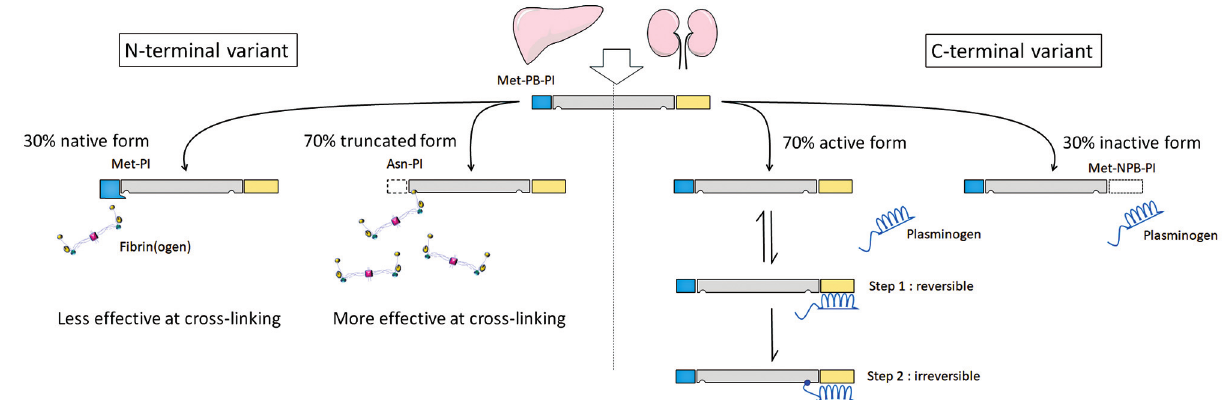
Fig. 2 Diversity ofcirculating PI terminus and their physiological effects. PI is expressedand released by the liver and the kidney as a single-chain plasmin-binding protein with a methionine (Met) residue at the N-terminus (Met-PB-PI). Posttranslational modi fi cations of N-terminal (blue box) and C-terminal ( yellow box ) result in several circulating PI forms. About 30% of PI circulates in plasma in the native. The remaining 70% of circulating PI is N-terminally cleaved between the proline (P) residue and the asparagine (N) residue and results in the truncated form Asn-PI, which is more effective at cross-linking. The C-terminal is found in plasma in two forms of which 70% is the full-length active form (Met-PB-PI) and 30% inactive (Met-NPB-PI). Only theactive form can bind to plasmin(ogen) via a two-step process which can either be reversible or irreversible. PI, plasmin